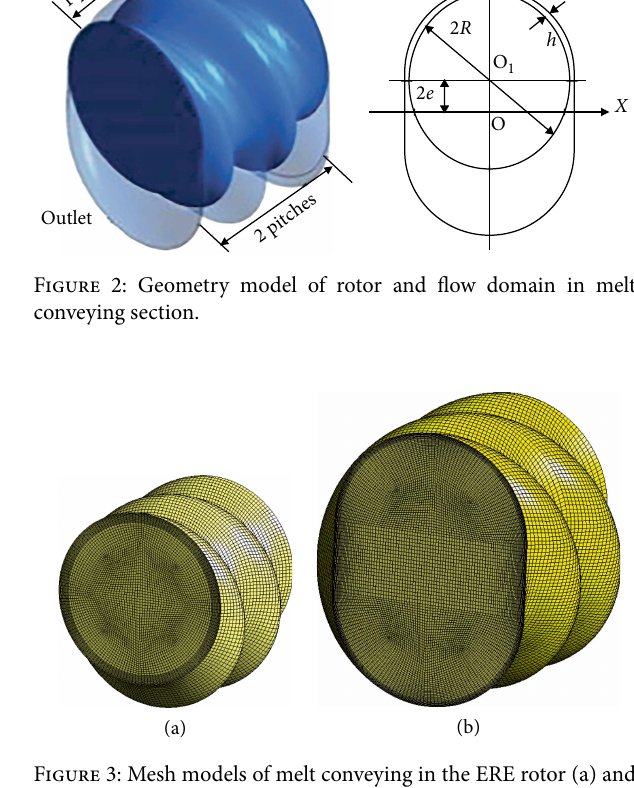
Figure 3: Mesh models of melt conveying in the ERE rotor (a) and stator cavity